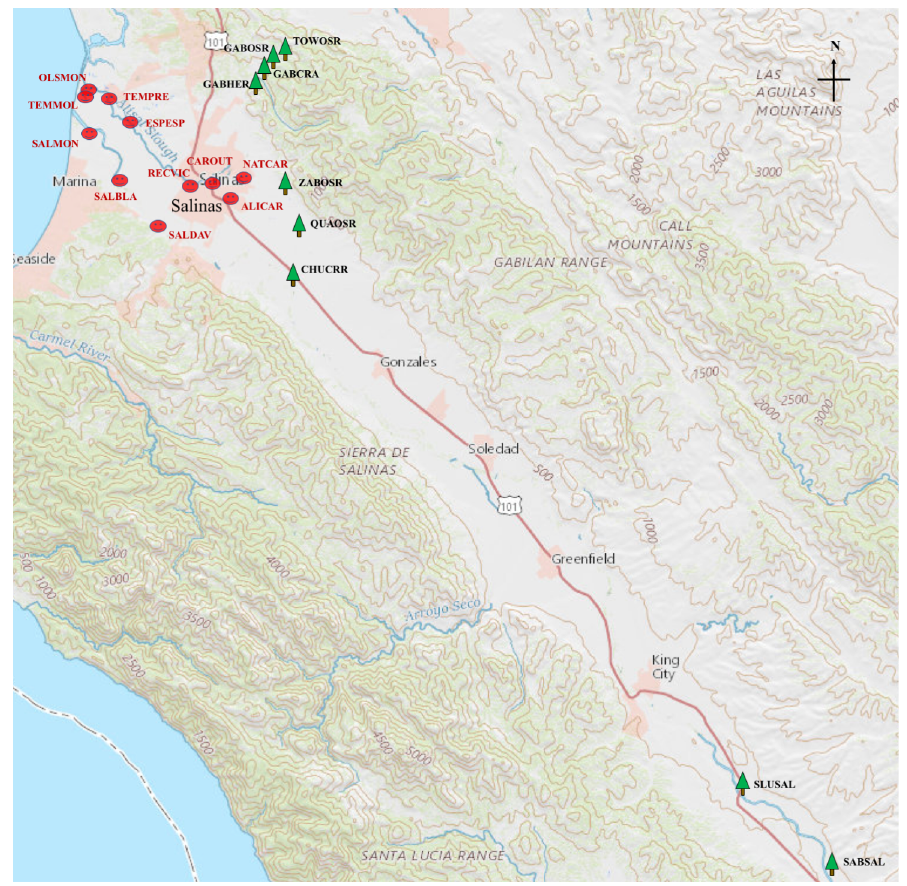
Fig 1. Geographical location of the watershed sites where the samples were collected in the area of Salinas Valley. Samplesites are labeledwith a six-letter acronym in black type (locationswith agriculture impact) or red type (locations with human impact). Insert is an expanded view of the area near the city of